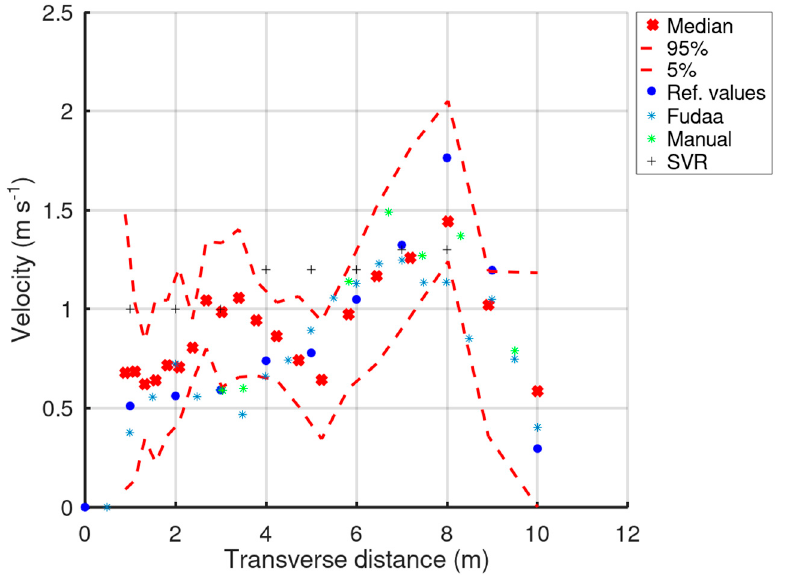
Figure 11. Loussios River at Atsicholos Bridge. Free-LSPIV 90% confidence interval and median values, the reference values, the surface velocities obtained with Fudaa-LSPIV, manually, and the SVR measurements.